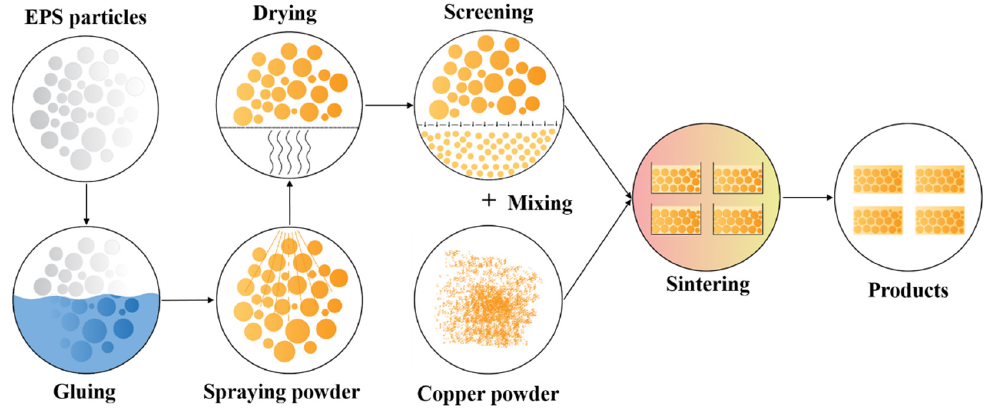
Figure 1. Schematic diagram of material fabrication